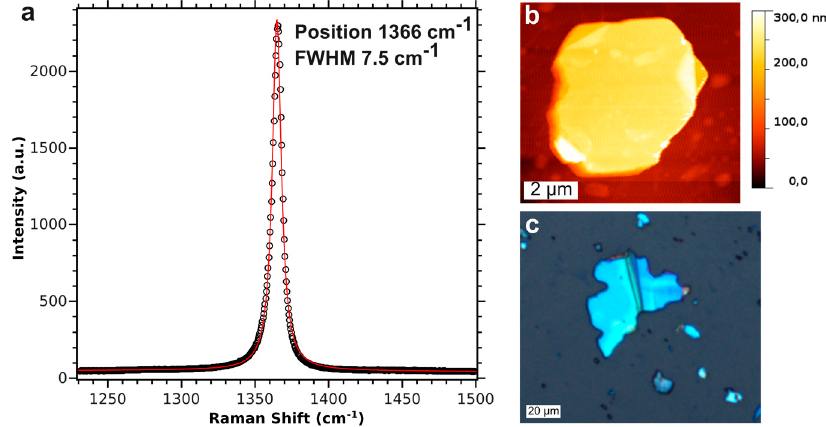
Figure 20. ( a ) Raman spectrum recorded on one h-BN single crystal flake; ( b ) AFM image of 300 nm- thick flake; ( c ) Optical image of a side-size flake up to 50 µm.